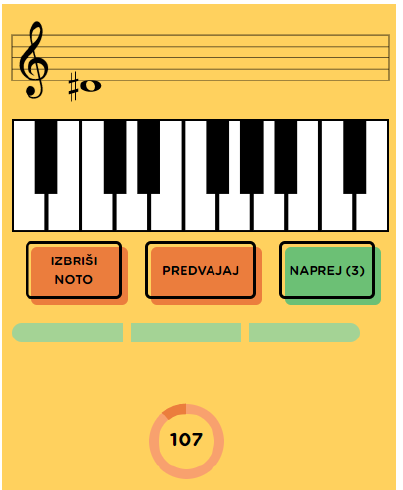
Figure 1. Interval dictation application.